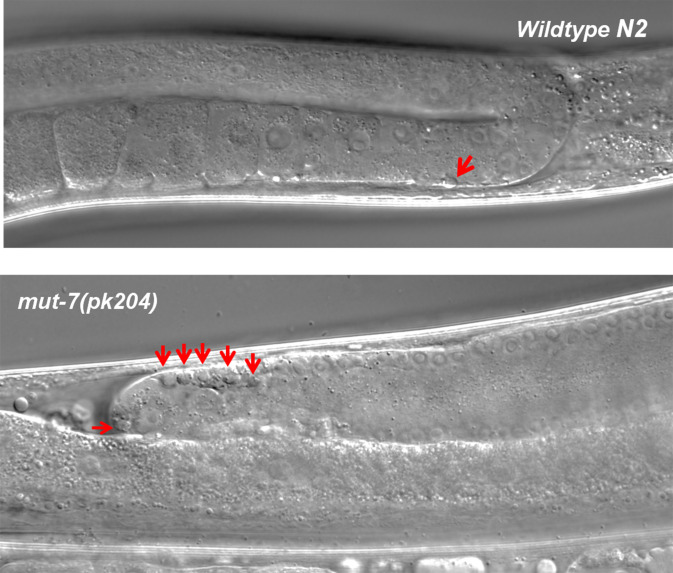
Images of cell corpses in wild-type and mut-7(pk204) animals.Cell corpses in each strain are indicated by red arrows.